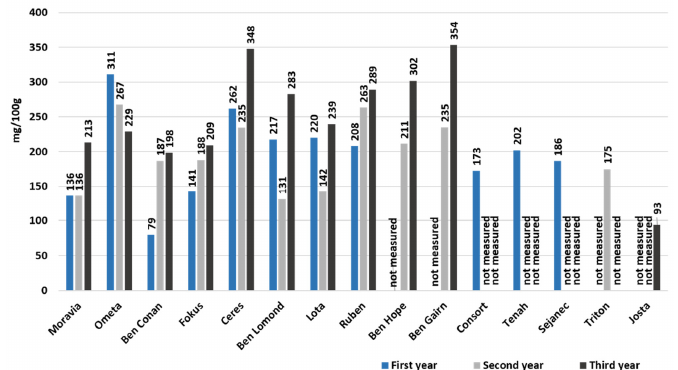
Figure 4. Total anthocyanin content (mg/100 g) in available blackcurrant cultivars measured during a three-year period (expressed as the sum of four major anthocyanins). Cultivars with the highest average total anthocyanin content (expressed as the sum of individual anthocyanins) were ‘Ben Gairn’ (294.38 mg/100 g), ‘Ceres’ (281.31 mg/100 g), and ‘Ometa’ (269.09 mg/100 g). These three cultivars were introduced into cultivation work at the turn of the new millennium. Their common denominator is earlier maturity and high yield potential. Other blackcurrant cultivars ranged between 154.74 mg/100 g and 256.55 mg/100 g; only hybrid ‘Josta’ had a significantly lower content (93.48 mg/100 g). The reported concentration of total anthocyanins content in blackcurrant fruits usually varies between 80–470 mg/100 g of fresh weight [1,4,11], which is in line with our results. Chromatograms of several real samples are presented in Supplementary material Figure S1. 4. Conclusions A new chromatography method for the fast separation of individual anthocyanins in blackcurrant cultivars has been developed. An Ascentis Express C18 150 × 4.6 mm, 2.7 µm, core shell particle chromatography column was chosen for fast and efficient separation. The developed method separated the major anthocyanins within 10 min while minor an- thocyanins were eluted till the 13th minute of the analysis. Compared to the available literature, analysis times were considerably shorter than the reported 30 min [2,9] or even fifty minutes chromatography runs [4,18]. Based on the real sample investigation, we can conclude that there is a considerable difference in anthocyanin contents among the ob- served cultivars and also within the years in the same cultivars, as was reported elsewhere [32]. Interestingly, the proportion (%) of anthocyanins in individual cultivars is almost unchanged over three years and seems to be specific to them. Cyanidin and delphinidin rutinosides are dominating compounds. The four main anthocyanins represented more than 92% of total anthocyanins in all blackcurrant samples, mostly about 98%, which is in agreement with previous works [12,13]. We suggest estimation of the total anthocyanin content in blackcurrant as the sum of four major anthocyanins rather than the equivalent of cyanidin-3-glucoside, as many authors do, because cya-3-glu is the least represented anthocyanin in blackcurrants, and it leads to underestimation of about 20%.